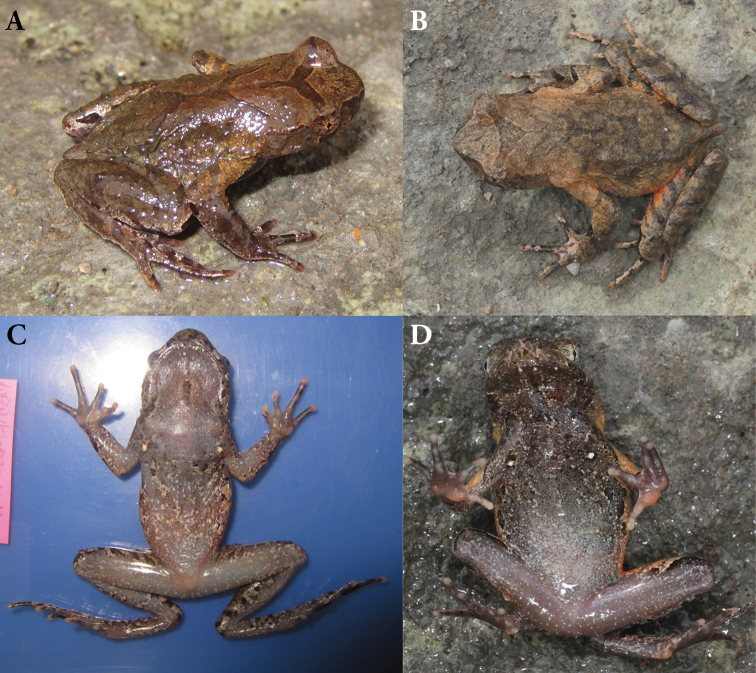
Colour variation in Megophrys
xianjuensis sp. nov. in life A, B dorsolateral view of a male (Voucher: CIBXJ190501) and a female (Voucher: CIBXJ190505), respectively C, D ventral view of CIBXJ190501 and CIBXJ190505, respectively.